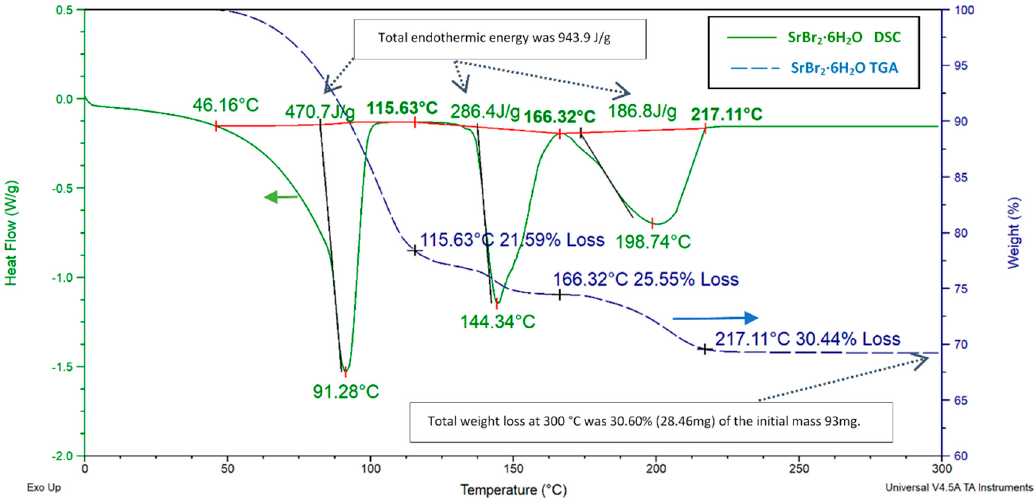
Figure 16. SrBr 2 · 6H 2 O TGA and DSC charts. For DSC, a 3 ◦ C · min − 1 heating rate from 0 to 300 ◦ C and a 20 ml · min − 1 N 2 flow rate were acquired. For the TGA test, the acquired method was a 3 ◦ C heating rate from 20 to 300 ◦ C without any gas flow.